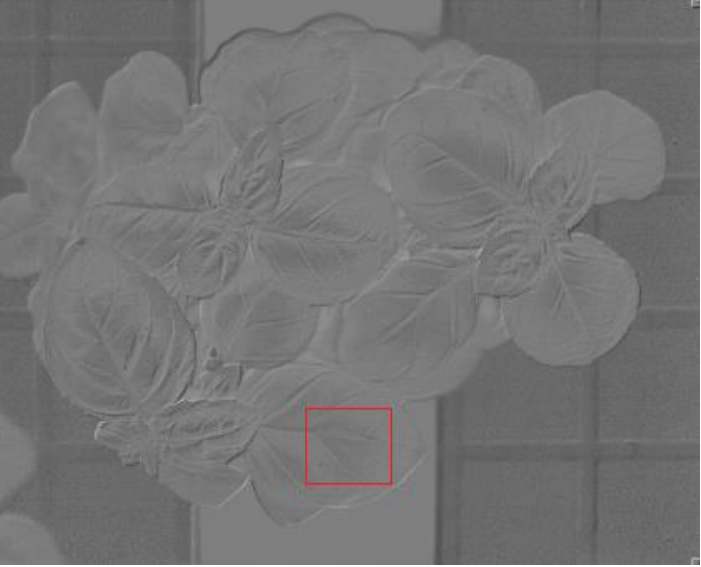
Figure 4. A manually selected image patch targeted the leaf area used for normalization the dataset. For every image patch, the least white pixel area was calculated, which was further used as the upper white value, and zero was used as the black limit in the normalization method. Consequently, all images were processed for normalization in order to change the range of pixel intensity values, create a consistent and comparable dynamic range of light exposure for the set of grayscale images and avoid visual noise (Figure 5). On the set of grayscale images, linear normalization was performed according to the following formula: